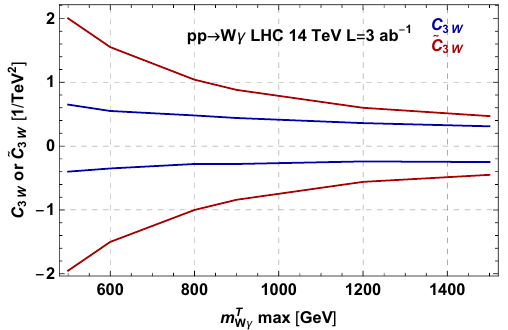
Figure 7 . 95% bound on the c 3 W and ~ c 3 W Wilson coe(cid:14)cients computed with angular (cid:30) W bins (de(cid:12)ned in the text) in function of the largest W(cid:13) system transverse mass bin used for the 14 TeV LHC with 3000 fb (cid:0) 1 of integrated luminosity. A systematic error of 5% has been